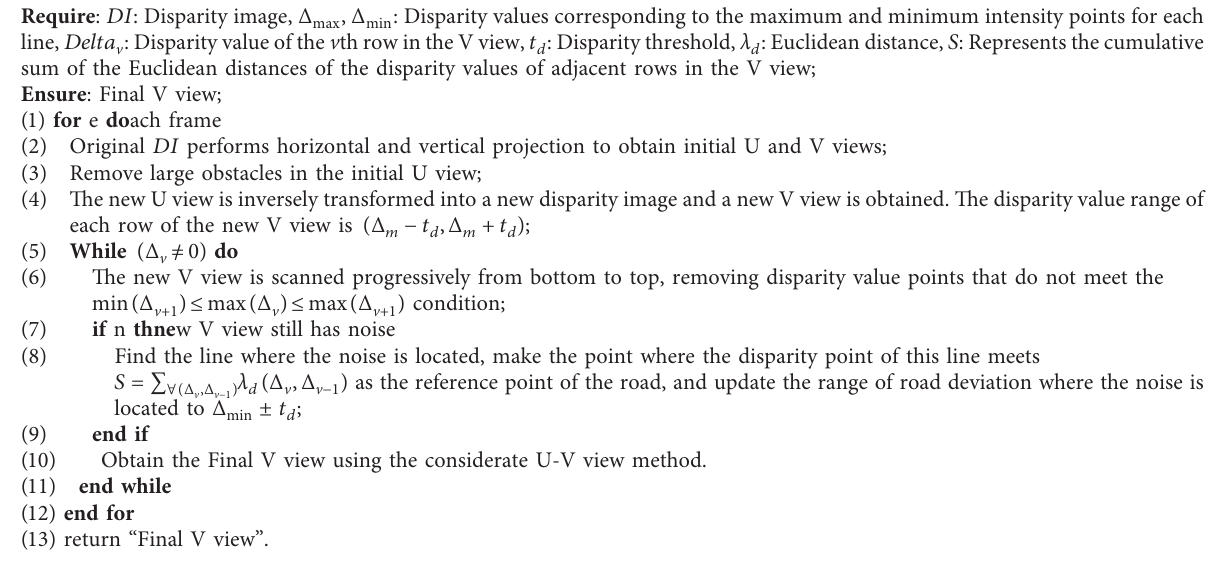
A LGORITHM 1: Road peripheral enveloping